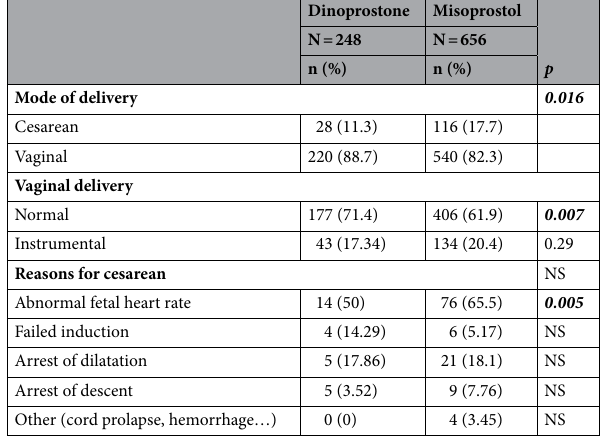
Table 2. Mode of delivery and cesarean indications. NS = Non-significant. Significant values are in